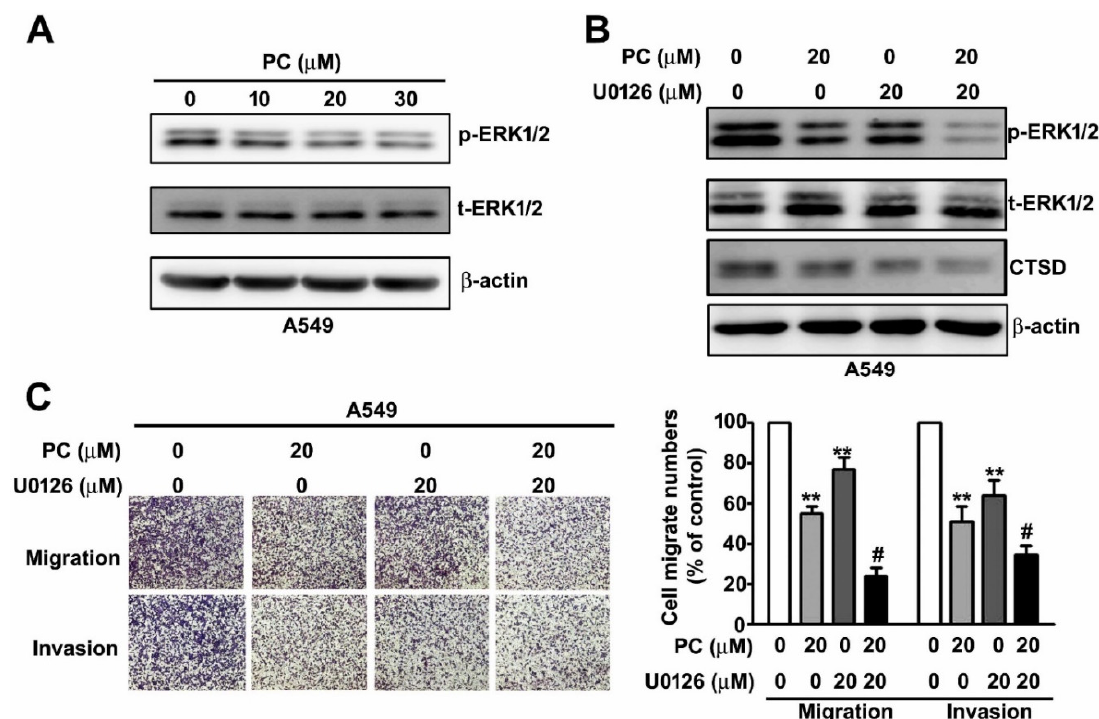
Figure 4. Synergistic inhibitory effect of PC and U0126 on cell migration and invasion by downregulation of the EKR1/2 signalling pathway. (A and B) Human A549 lung cancer cells were treated with PC in the presence or absence of U0126 (a specific MEK1/2 inhibitor) and then harvested for an immunoblotting assay to observe the activation of the EKR1/2 signalling pathway and CTSD protein expression. (C) Human A549 lung cancer cells were treated with various concentrations of PC (0 and 20 μ M) and/or U0126 (0 and 20 μ M) for 24 h, and subsequently their capacity for cell migration and invasion was measured. ** p ＜ 0.01 versus control (line 1); #, p ＜ 0.05 versus PC treatment (line 2). (Mean ± SE, n = 3).